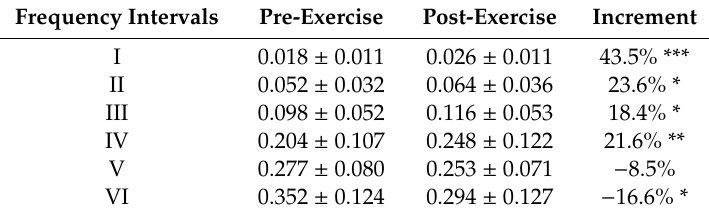
Figure 5. Comparison of normalized energy in 6 frequency intervals between the pre-exercise (gray bar) and post-exercise (black bar) rest phase. Statistical significance: * p < 0.05, ** p < 0.01, *** p < 0.001. Table 1. Normalized wavelet energy in the 6 frequency intervals.